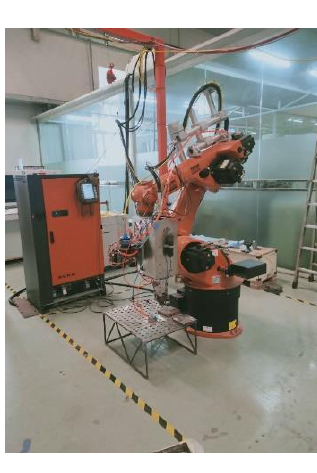
Figure 2. Laser-cladding system.